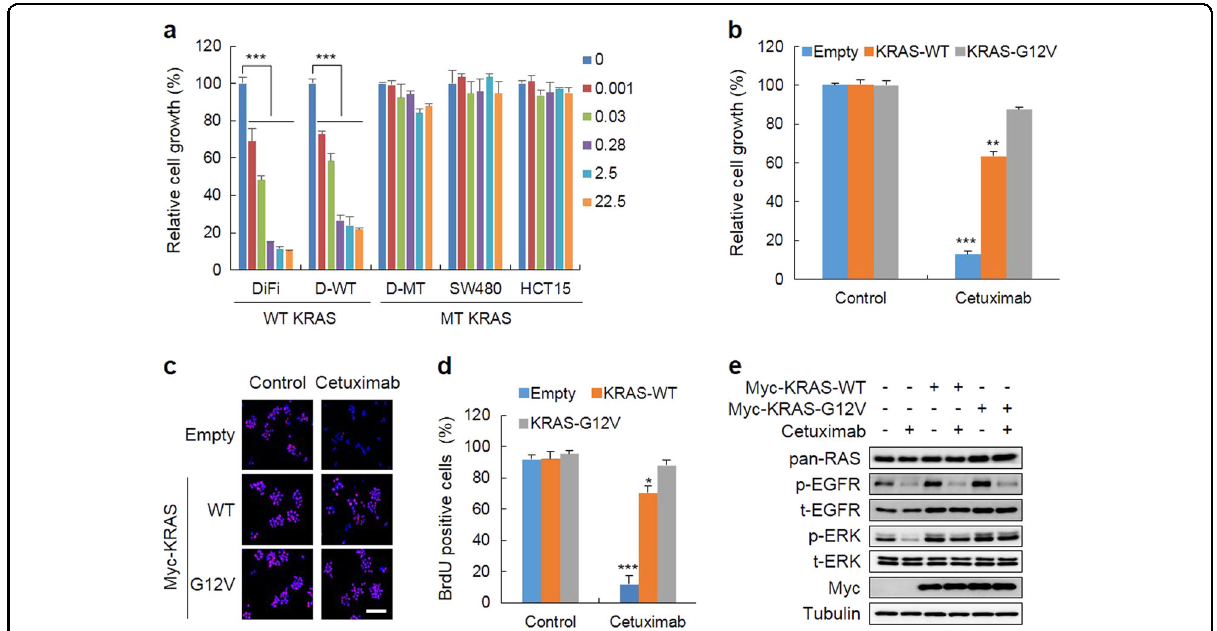
Fig. 2 The overexpression of WT KRAS, as well as the mutant form, contributes to the resistance to cetuximab. a MTT assays were performed to determine the effects of cetuximab on the growth of various CRC cells treated with the indicated doses of cetuximab for 96 h. b – e The effects of the overexpression of KRAS WT or oncogenic mutant G12V on cell growth. The D-WT cells stably expressing Myc-KRAS-WT, -G12V, or empty vector were treated with 5 µg/mL cetuximab for 96 h. MTT ( b ) and bromodeoxyuridine (BrdU) incorporation ( c , d ) assays were performed to measure cell proliferation. Scale bar, 100 µm. The WCLs were subjected to IB analyses ( e ). The data are presented as the mean ± SD ( n = 3). Two-sided Student ’ s t- test, * P <0.05, ** P <0.005, and *** P